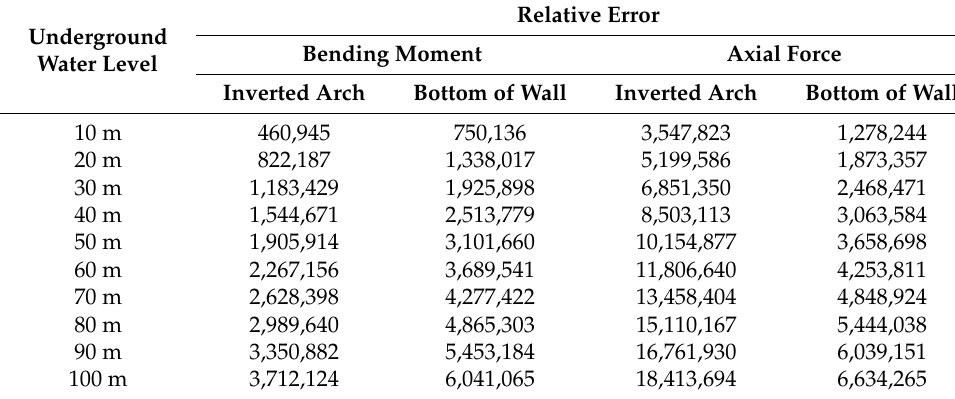
Table 2. Comparison between the actual water pressure and the equivalent simulated water pressure at the inverted arch and the bottom of the